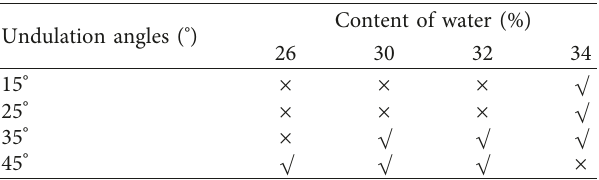
Figure 10: Test procedure of macropore structure formation. (a) The process of making the sample. (b) Final sample. Table 3: Relationship between slope angle, slurry consistence, and macropore structure.